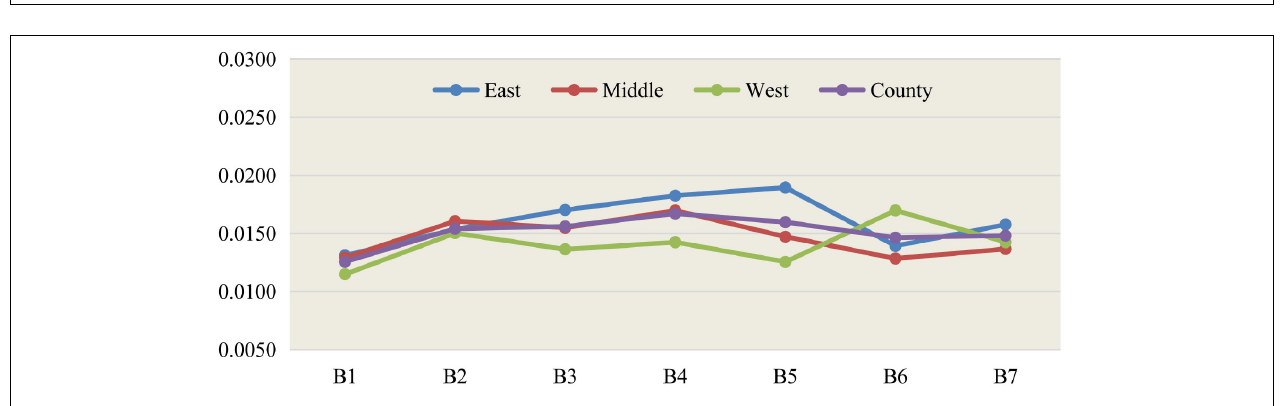
FIGURE 1 | Line chart of social development level scores of three regions from 2011 to 2015.